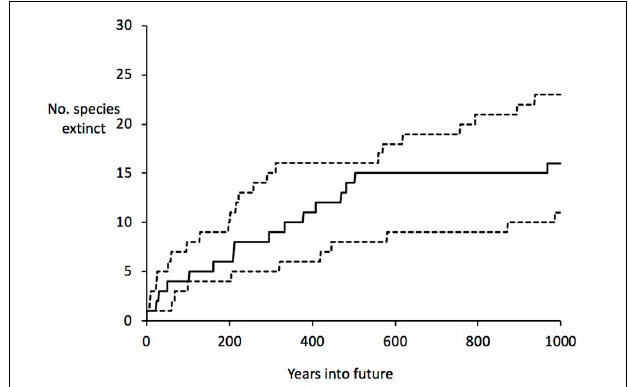
FIGURE 2 | Projected extinctions over time (next 1000 years), based on current threat levels. Upper and lower estimates are given as well as the central estimate (middle).